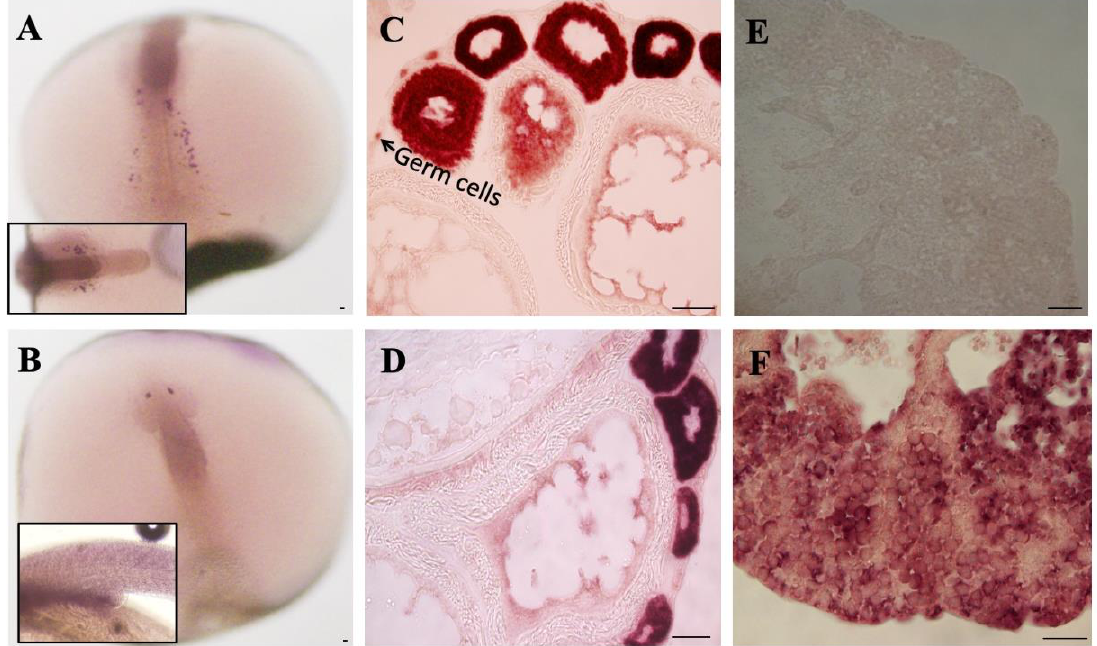
Figure 3. Cellular localization of sxl1a and sxl1b in embryos and adults by WISH and ISH . At stage (S)-17, sxl1a was specifically expressed in germ cell precursors ( A ), while sxl1b was localized in the optic region ( B ). Insets in both ( A ) and ( B ), marked with a black boundary, show the olvas expression at S-17 and sxl1b expression at S-33, respectively. Interestingly, during adulthood, sxl1a was specifically expressed in the female germ cell and early oocytes ( C ) but not in testis ( E ). On the other hand, sxl1b was abundant in the female early oocytes ( D ) and both germ and somatic cells of testis ( F ). Bar length- 50 µm.